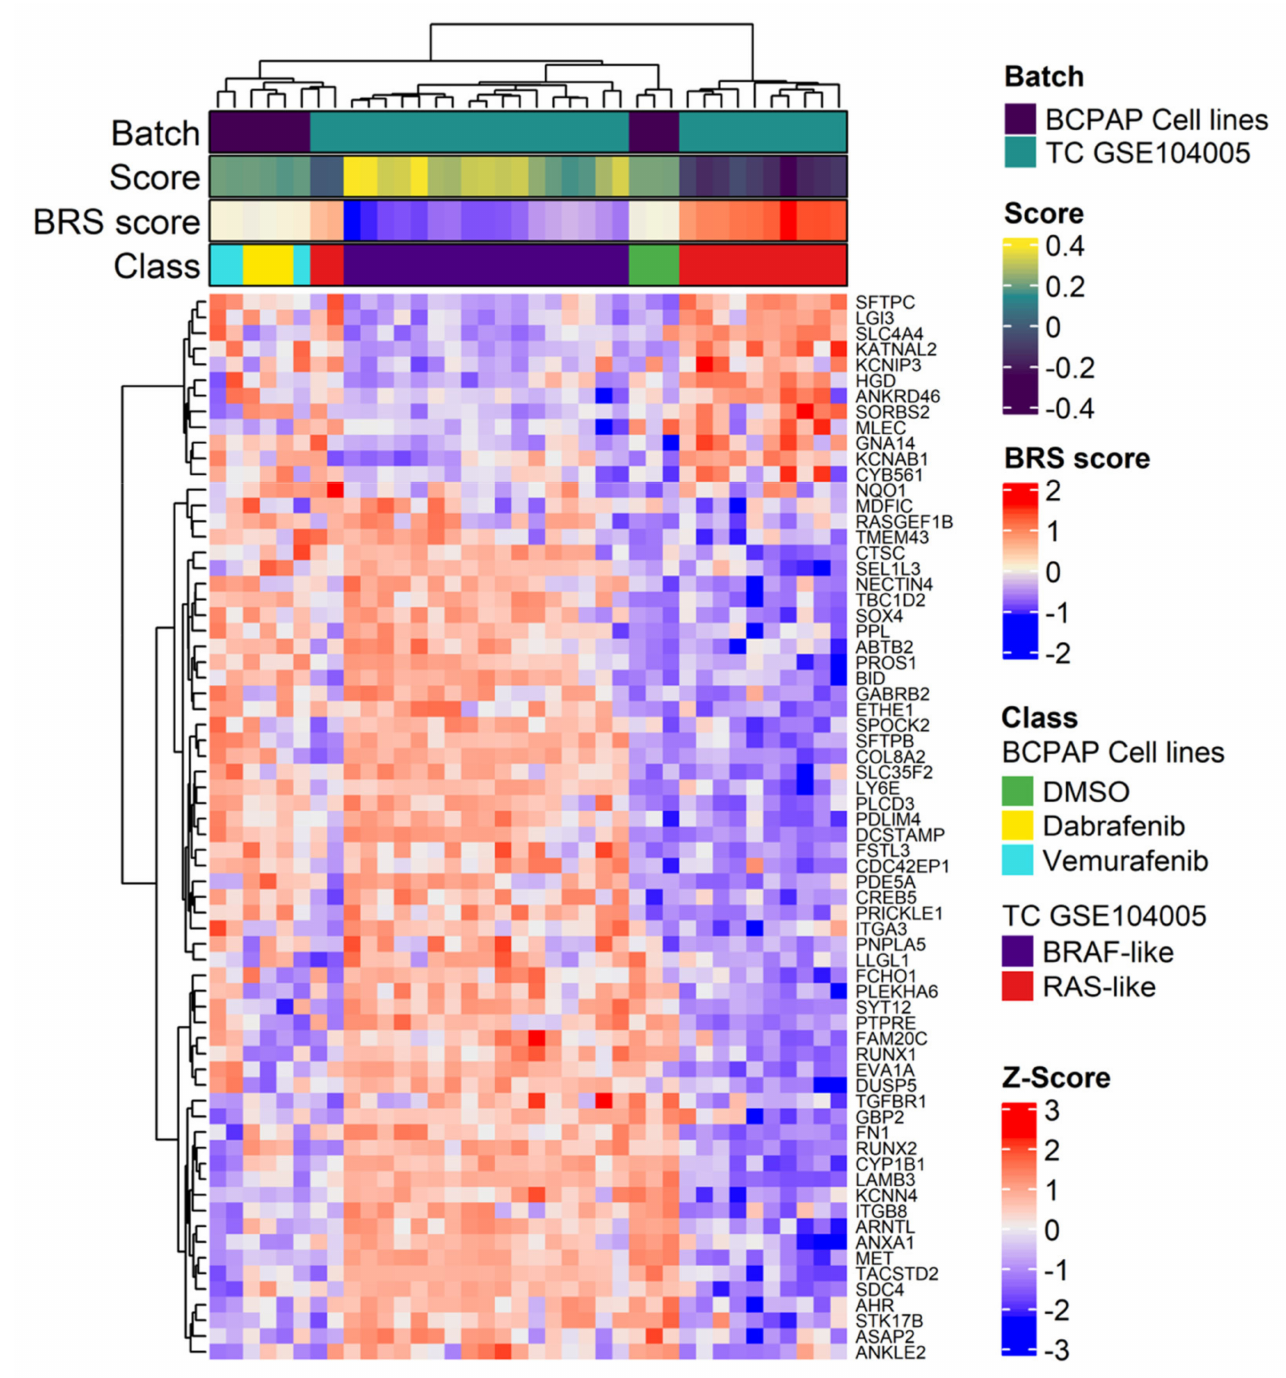
Figure 6. Unsupervised hierarchical clustering using the BRAF-RAS signaling gene signature in BCPAP cells and in thyroid cancer tissues. Heatmap showing the expression pattern of the genes, reported as Z-scores, included in the BRAF-RAS like signature evaluated in the merged datasets, including the BCPAP cells and the human thyroid cancer (TC) tissues derived from the gene dataset GSE104005. Specific sample features are showed separately in the colored bar above the heatmap: Batch, either BCPAP cell lines or GSE104005 samples; Score, BRAF − /RAS-like subtype gene scores calculated with singscore; BRS, BRAF-RAS score; Class, BCPAP cell lines stratified for treatment; TC tissues from GSE104005 dataset stratified for BRAF/RAS subtype; Z-Score, colored bar z-scores